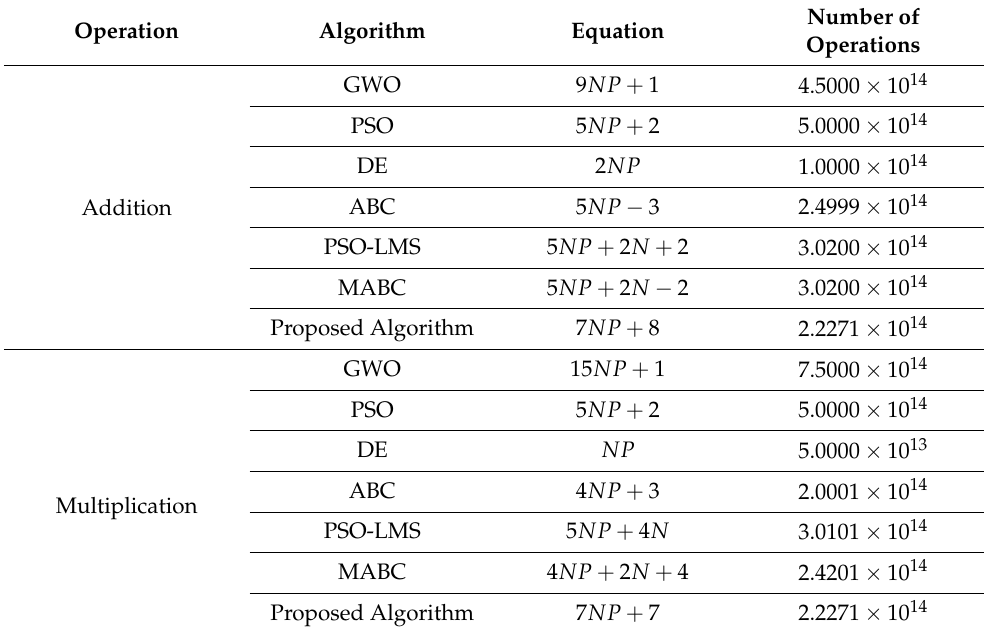
Figure 6. ERLE of the proposed Markov switching PSO algorithm and existing approaches [18–23] by computing the AR(1) process input signal when multiplying the acoustic path by − 1 at the middle of the adaptive filtering process. Table 2. Number of additions and multiplications required by the conventional PSO algorithm [17] and the proposed